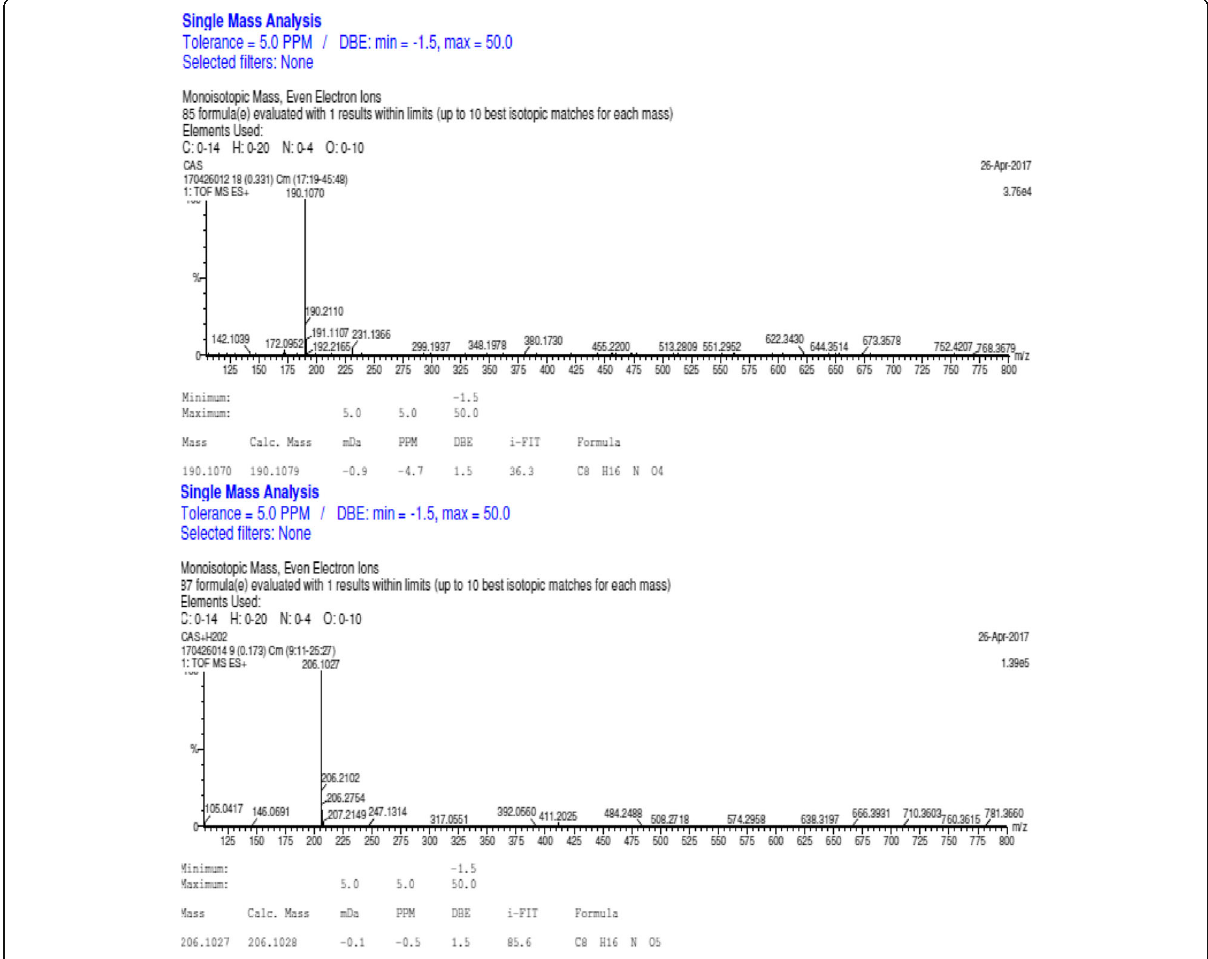
Fig. 6 HR-MS spectrum of castanospermin and its n-oxide